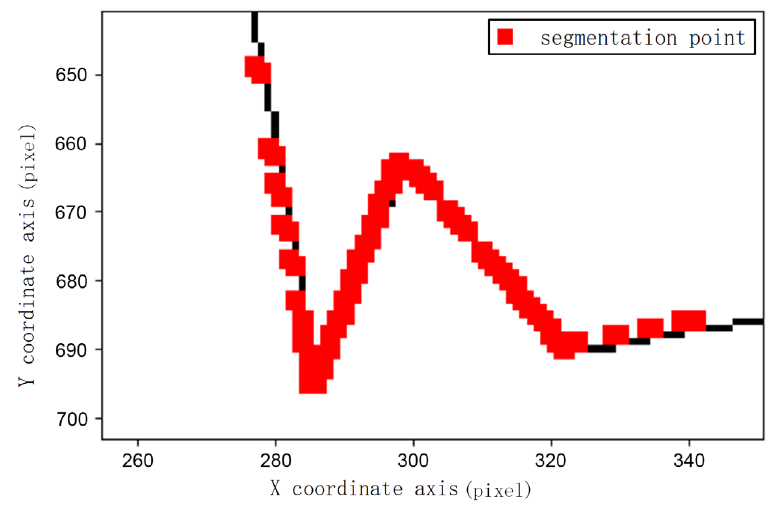
Figure 11. All shorter graphic elements being considered as segmentation points.